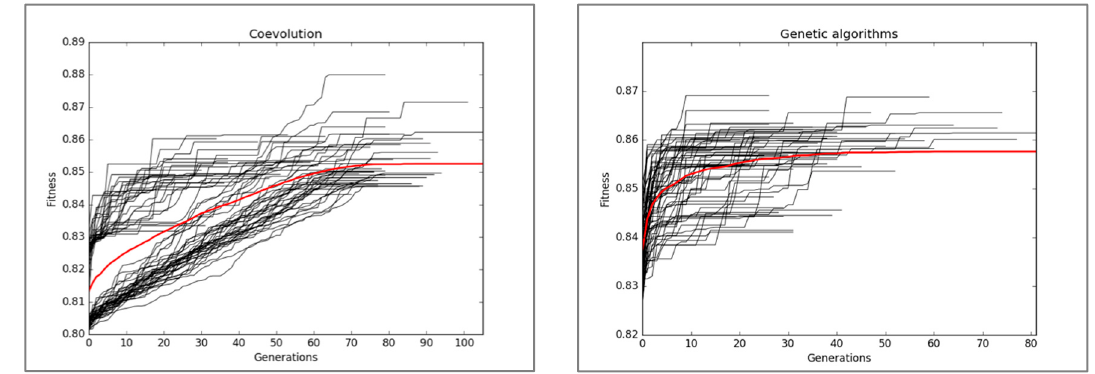
Figure 8. Fitness convergence characteristics obtained from 50 independent runs of CC ( left ) GA ( right ).